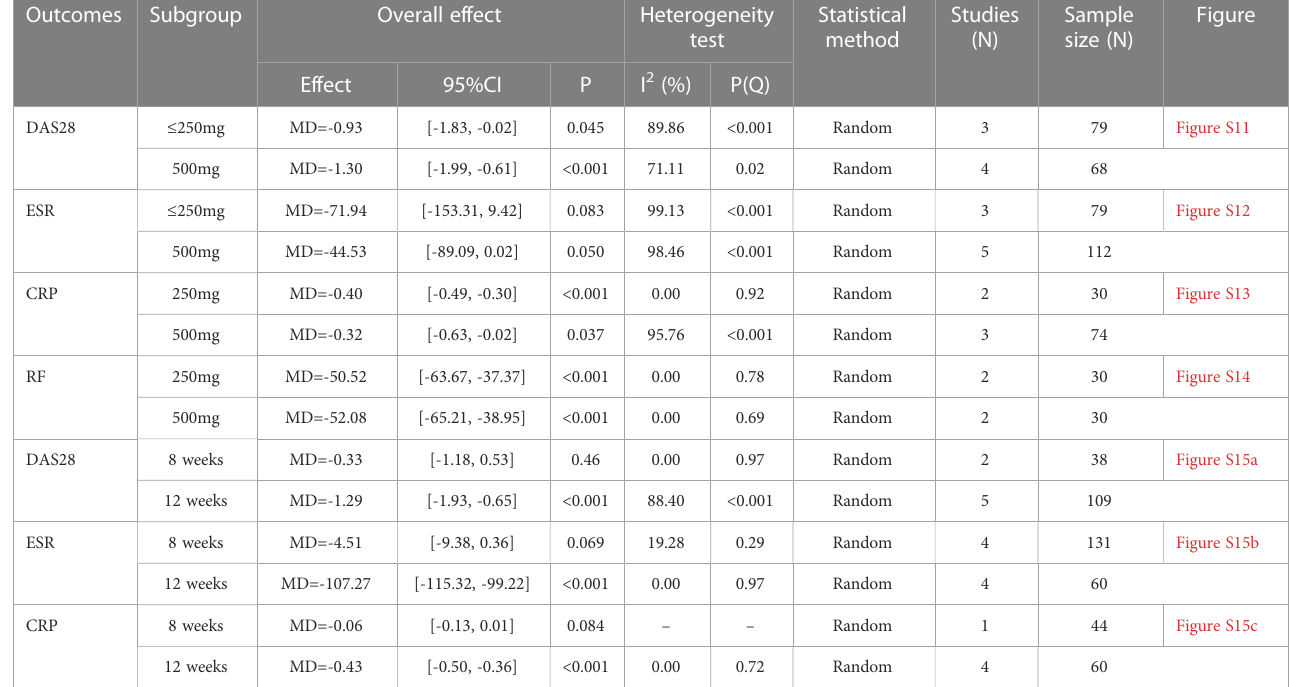
TABLE 3 Subgroup analysis results of